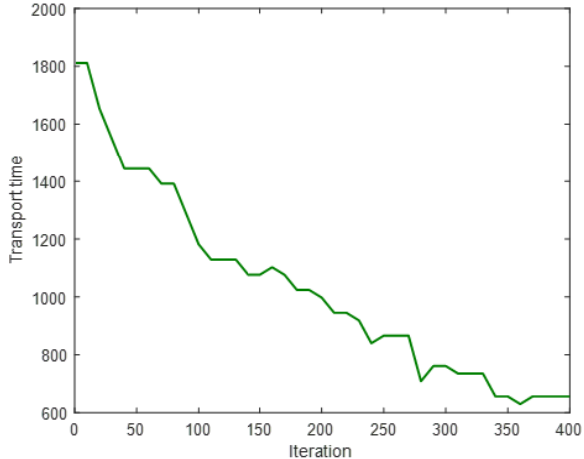
Figure 9. GA algorithm time target iteration